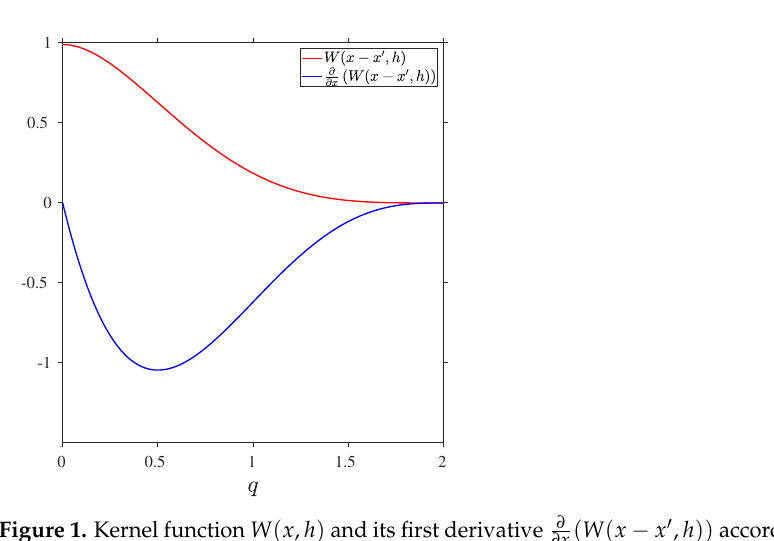
Figure 1. Kernel function W ( x , h ) and its first derivative ∂ and